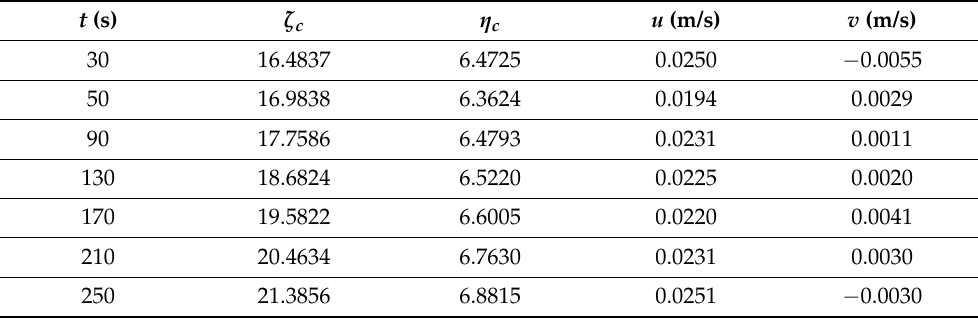
Table 1. Data of time and the geometrical center between each contour.